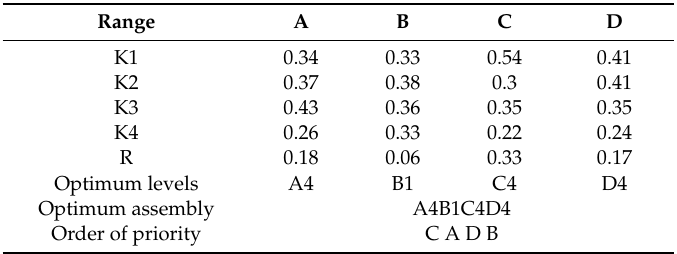
Figure 6. The effects of the laser volumetric energy density variation. ( a ) Dimensional accuracy; ( b ) warpage. Table 5. Range analysis of warpage.